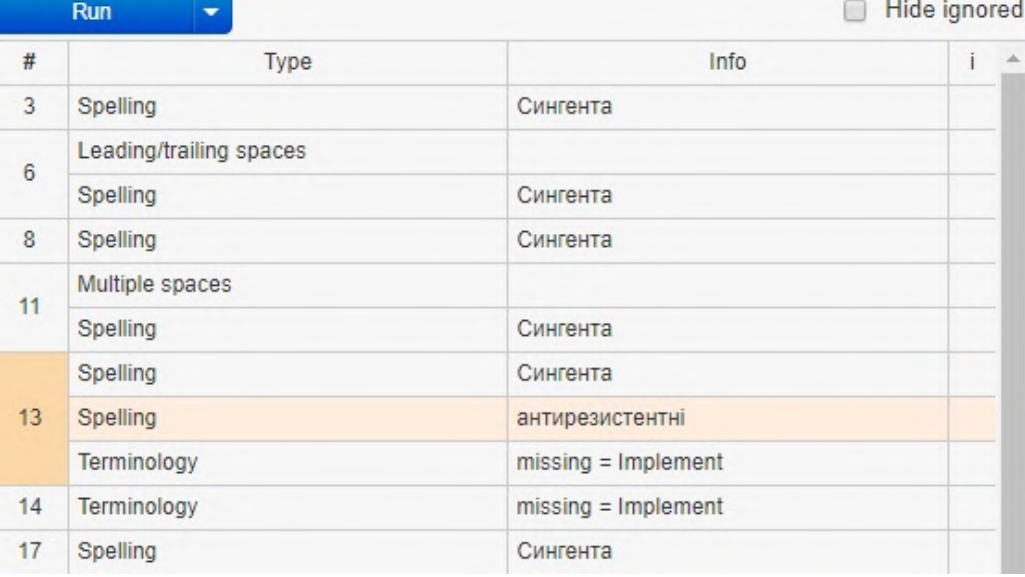
Figure 6: Checking spelling in Memsource.